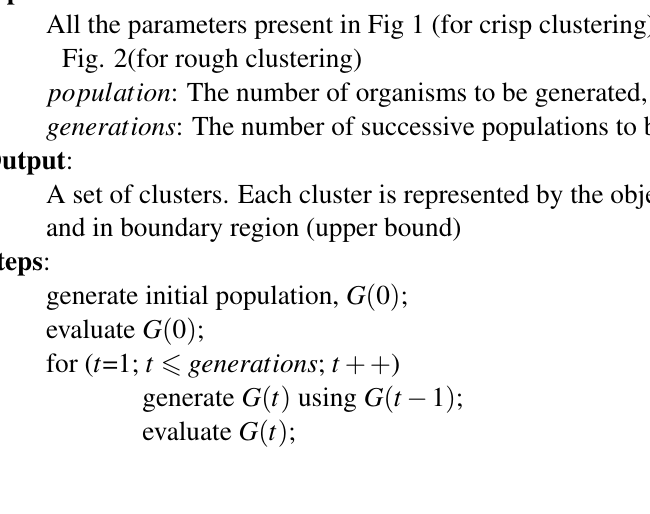
Figure 3: Steps used in the GA based Evolutionary algorithms change. The Fitness value for the rough